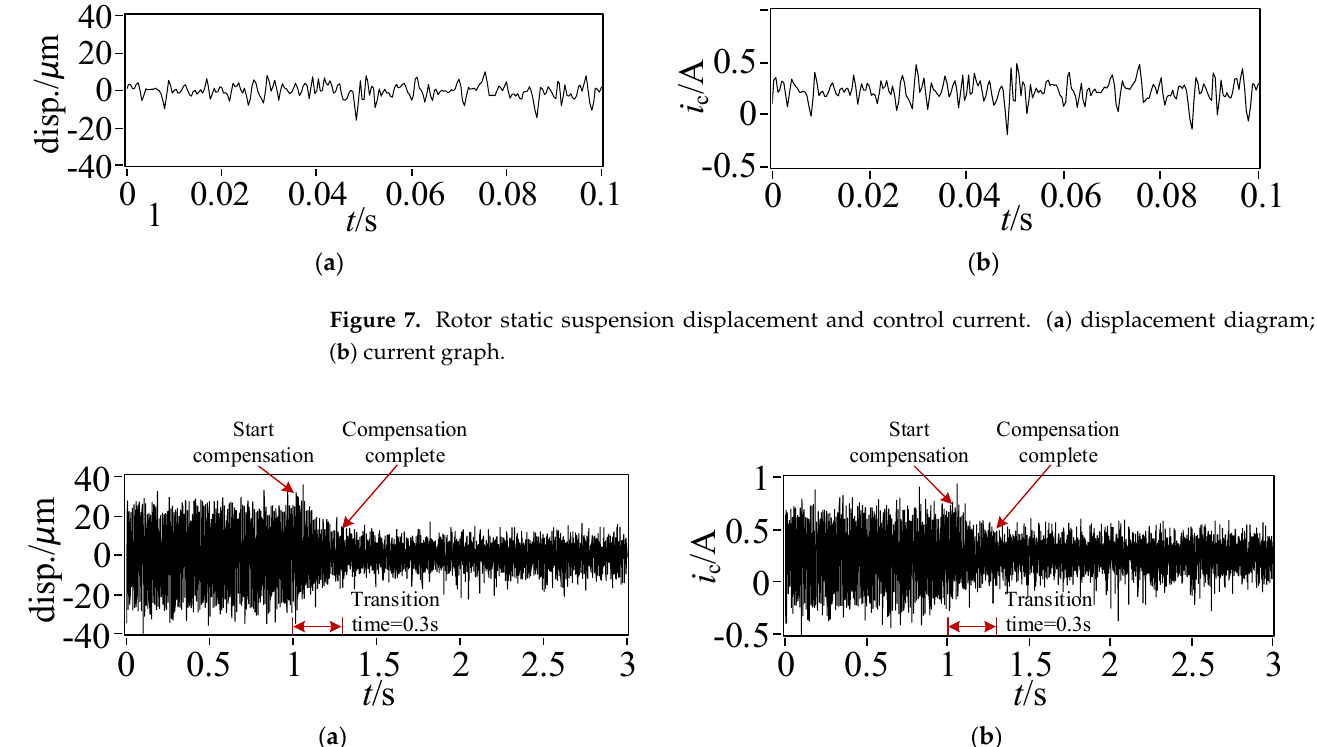
Figure 6. Experimental platform.